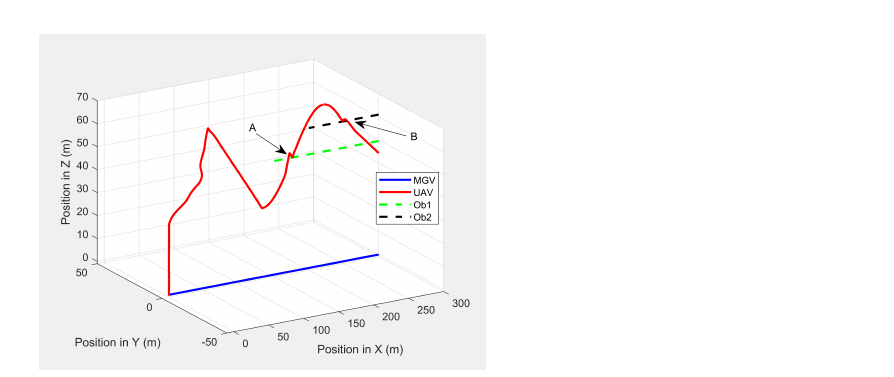
Figure 23. The UAV’s planned path in 3D when following the MGV in the presence of dynamic obstacles.